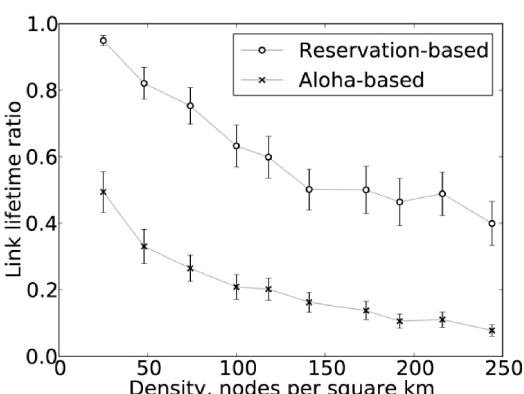
Figure 7. Mean connectivity ratio by degree for bidirectional links: experimental